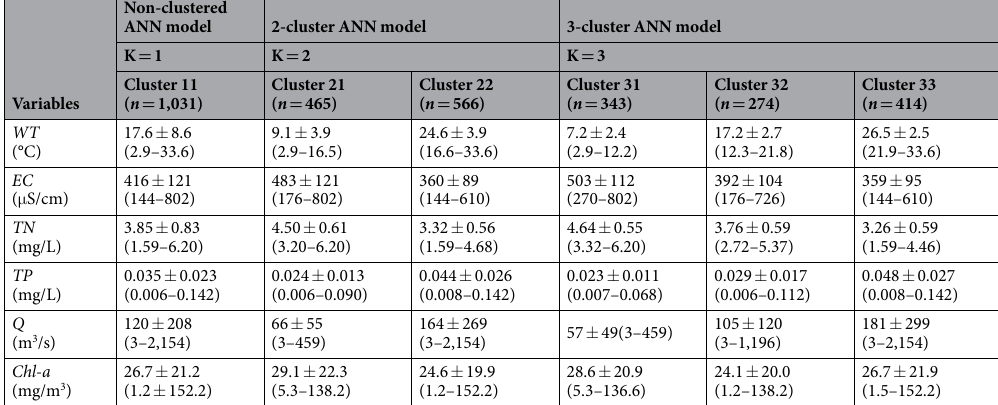
Table 2. Summary of clustered inputs ( WT , EC , TN , TP , Q ) and output ( Chl-a ) data collected at Goryung station.